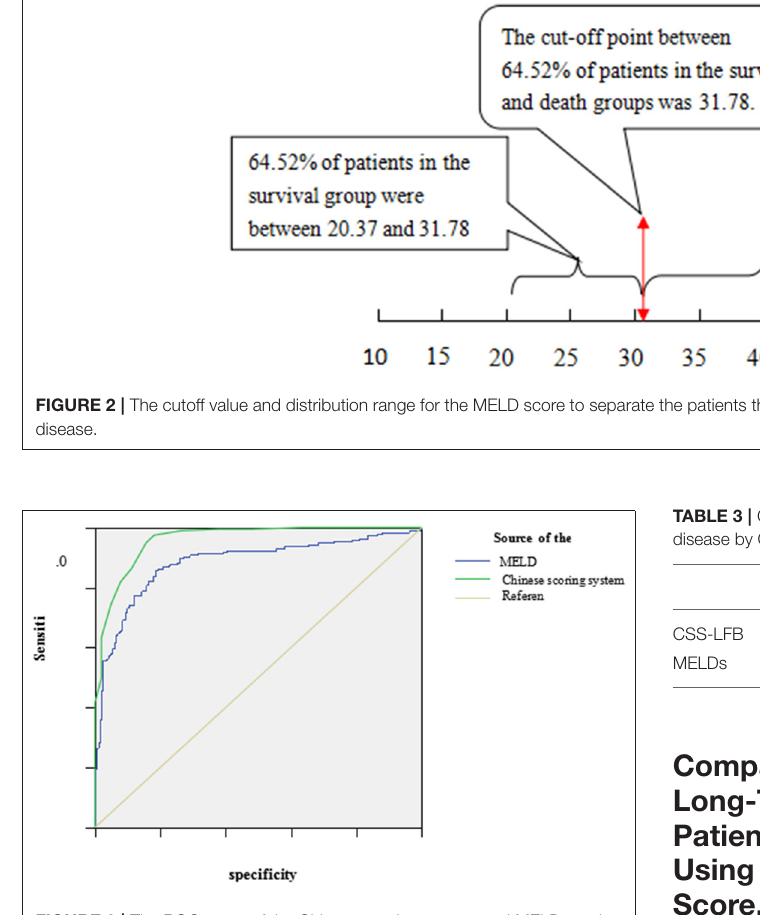
FIGURE 3 | The ROC curve of the Chinese scoring system and MELD scoring system at the peak disease. MELD, model for end-stage liver disease; ROC, receiver operating characteristic.